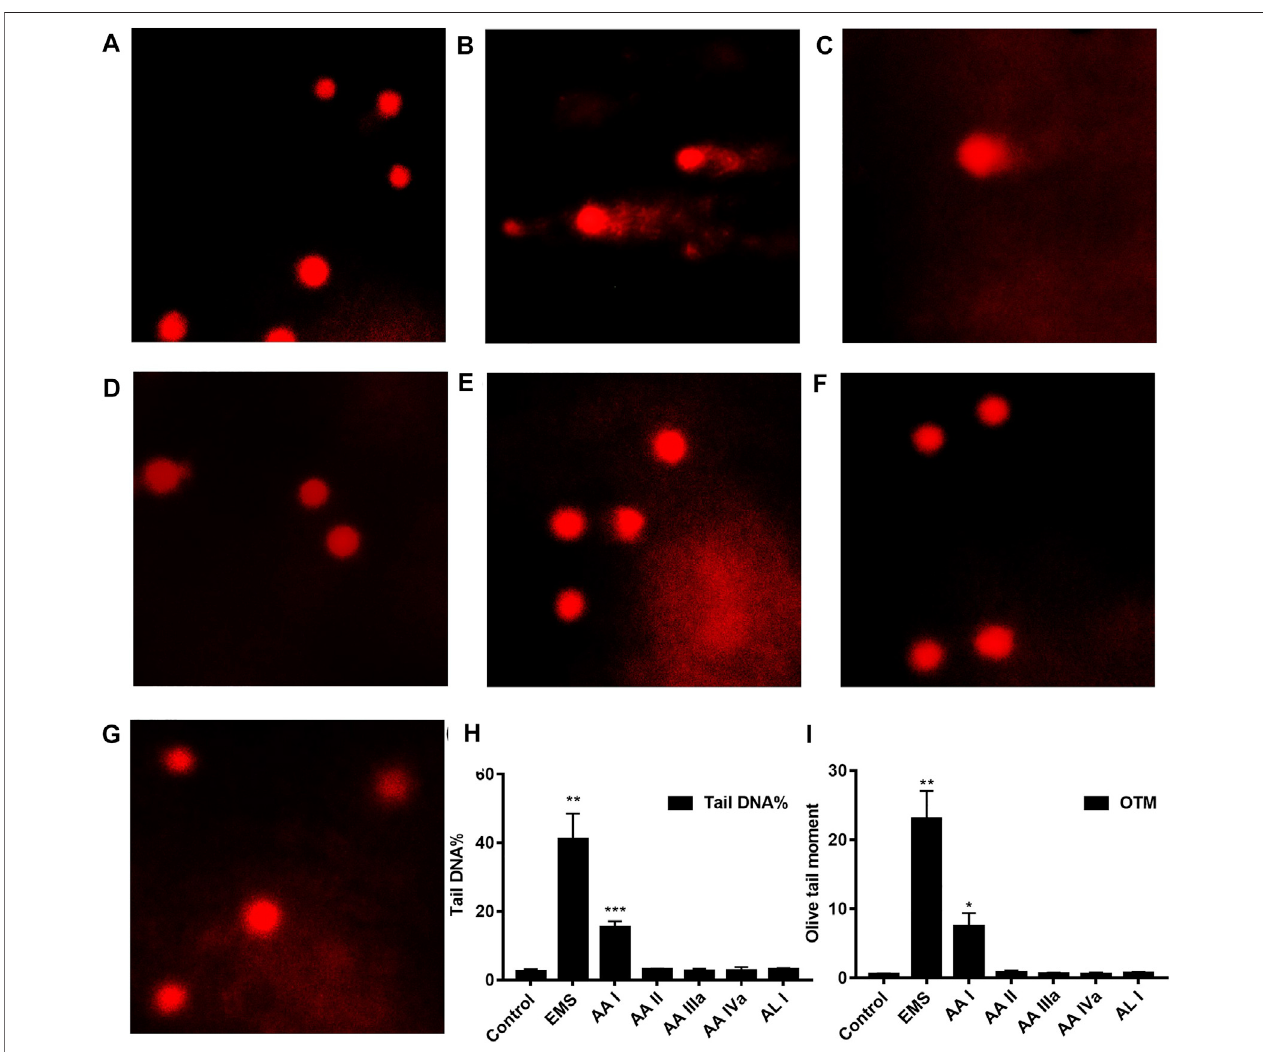
FIGURE 6 | Comet assays: control (A) , EMS (B) , AA I (C) , AA II (D) , AA IIIa (E) , AA IVa (F) , AL I (G) . The tail DNA% (H) and olive tail moment (OTM) (I) of renal cells frommicetreatedwithAAI(20 mg/kg).Datawerecalculatedfrom100cellsandone-wayANOVAwasusedforstatisticalandsigni fi canceanalysis.* p < 0.05;** p < 0.01; *** p <